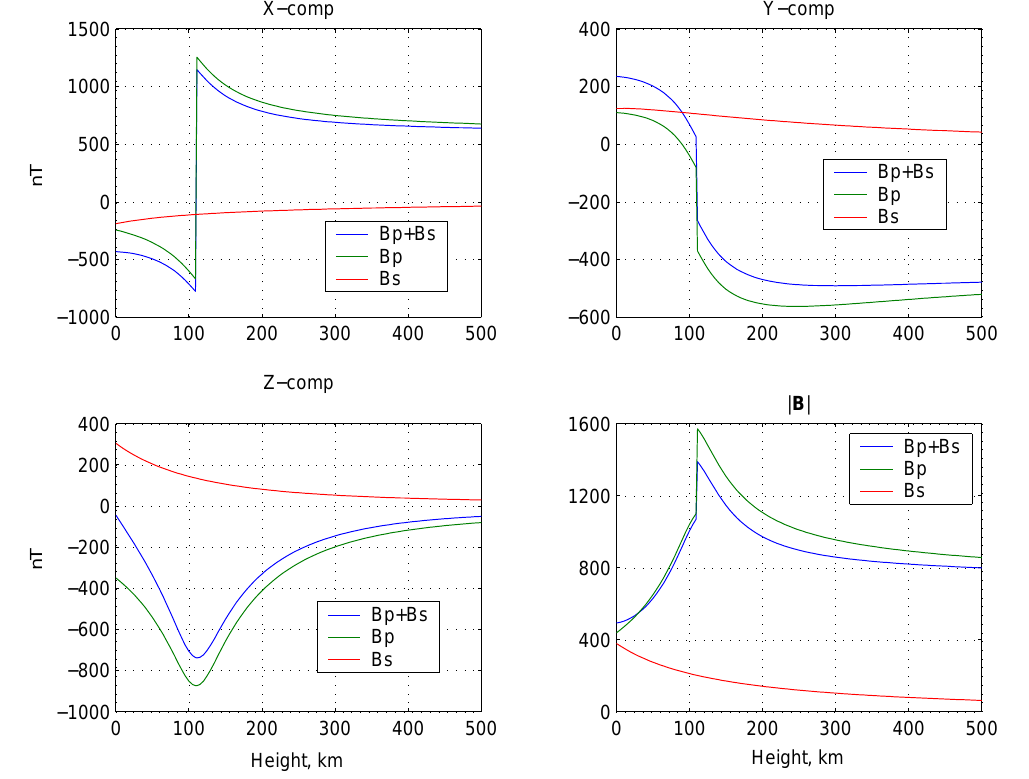
Fig. 9. Height profile of the primary and secondary magnetic fields at position x=100km, y=200km of the (cid:127) -band model.